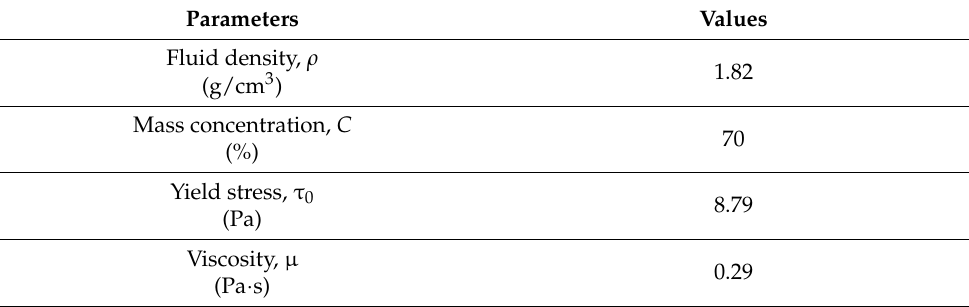
Table 2. Parameters in numerical